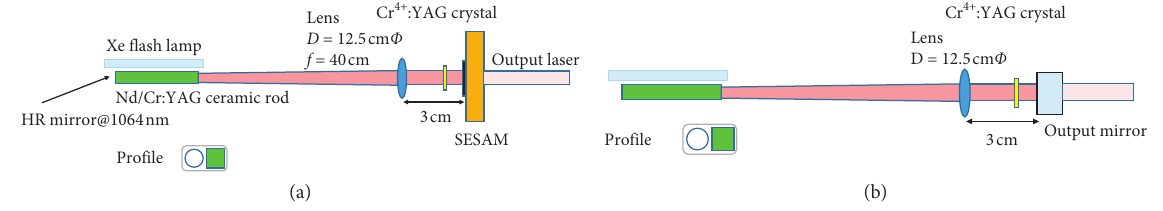
Figure 1: Experimental setup (a) using a SESAM and (b) using only a Cr 4+ :YAG crystal. Table 1: Bandwidth and TLP for each laser material. Ti:sapphire